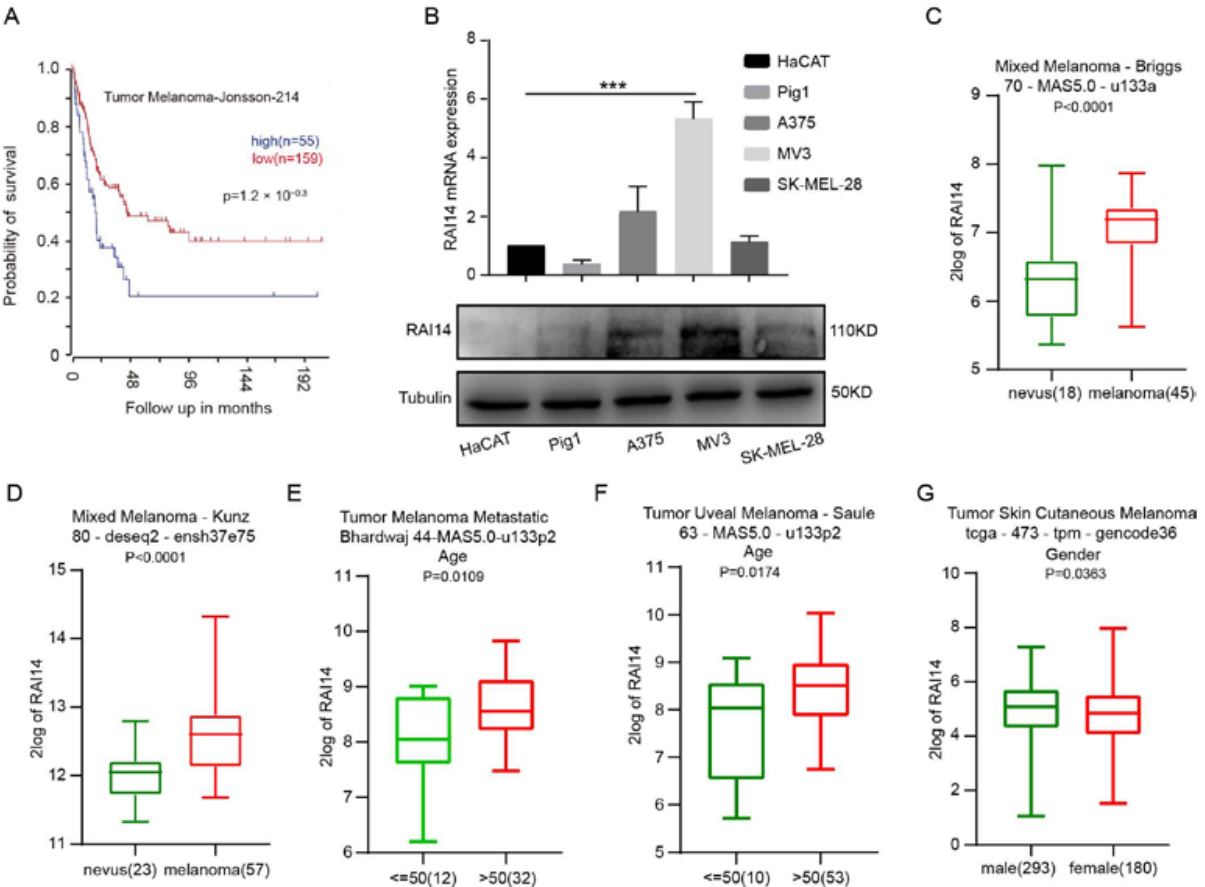
Figure 1. High expression of RAI14 is associated with poor prognosis of melanoma. ( A ) Result of the Kaplan–Meier analysis of progression-free survival and the log-rank test p values are from Tumor Melanoma-Jonsson-214 in R2 database. ( B ) qRT-PCR and Western blot were used to examine expression of RAI14 in melanoma cell lines (A375, MV3 and SK-MEL-28), normal human epidermal melanocytes (Pig1) and human immortalized epidermal cells (HaCAT). ( C , D ) Comparison of RAI14 expression levels in nevus and melanoma by database. ( E – G ) The relationship between RAI14 expression and patient’s age and gender. The data were expressed as mean ± SD. Student’s t test and One-way ANOVA were performed to analyze significance. *** p < 0.001.